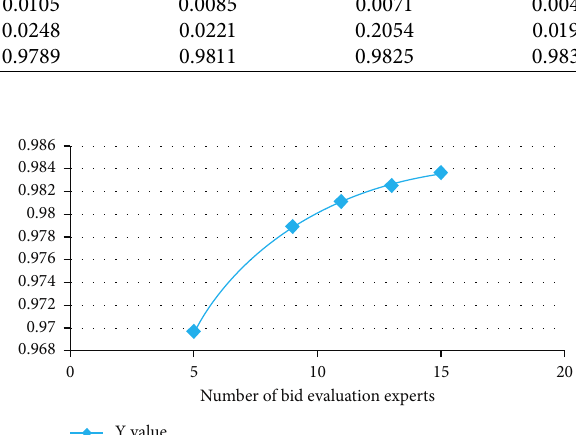
Figure 4: The relationship between the number of experts and the generalization coefficient. Table 5: Change of generalization coefficient and increase in ∆ E ρ